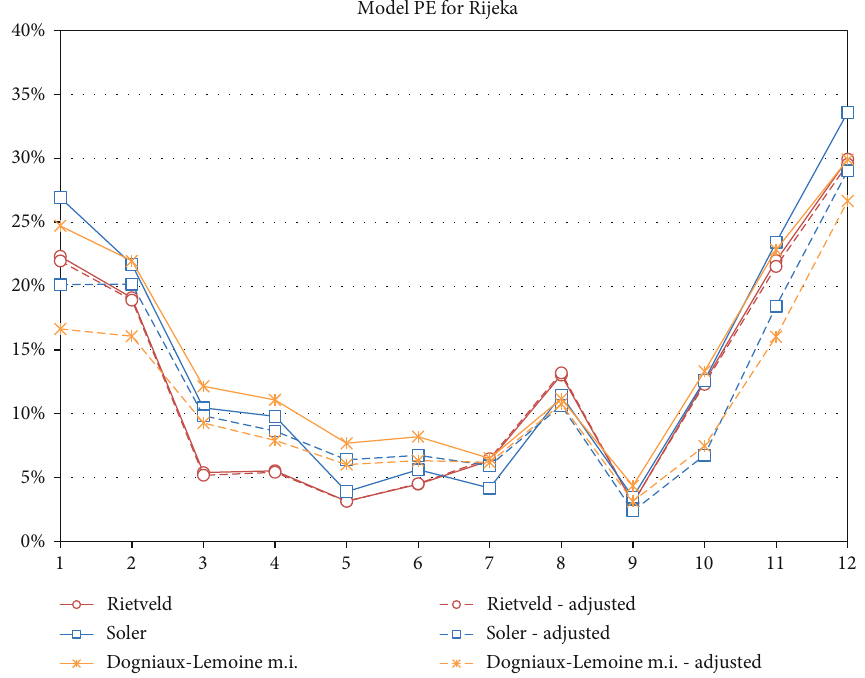
Figure 4: Comparison of percentage error of original and adjusted models for